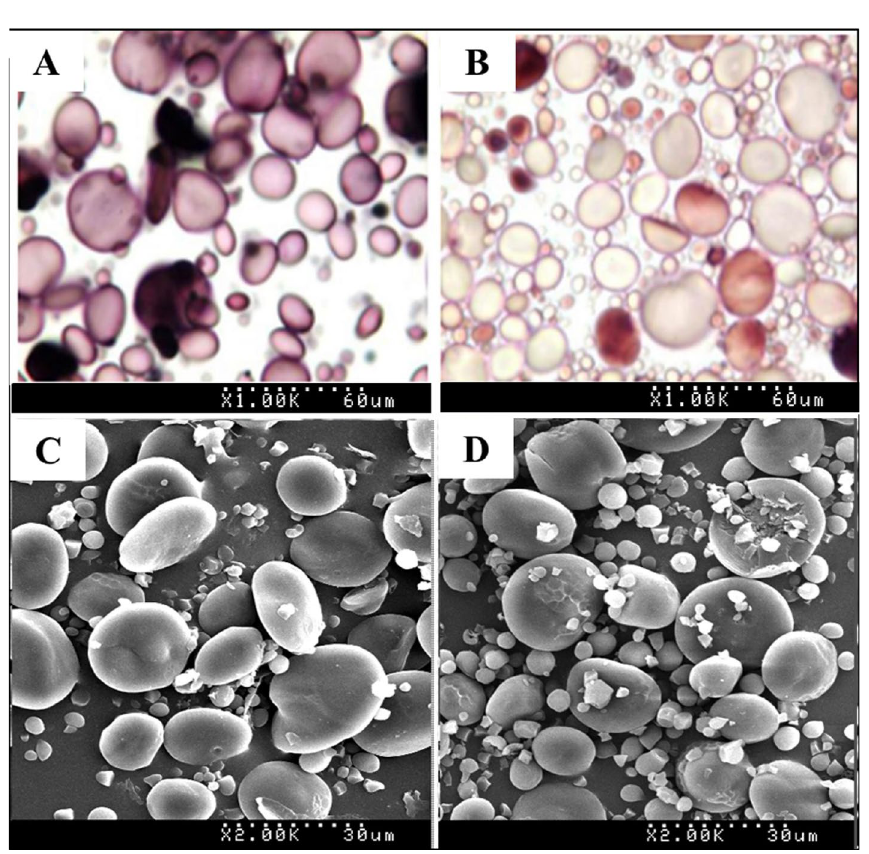
Figure 2. Starch granule staining and structure analysis. Starch granule staining by I 2 -KI solution (1000 diameters). ( A ) Wild-type; ( B ) Wx-null line. Starch structure visualized by SEM (2000 diameters). ( C ) wild- type; ( D ) Wx-null line. The total length of the white dots at the bottom of the picture represents 60 µm (1000 diameters) and 30 µm (2000 diameters),